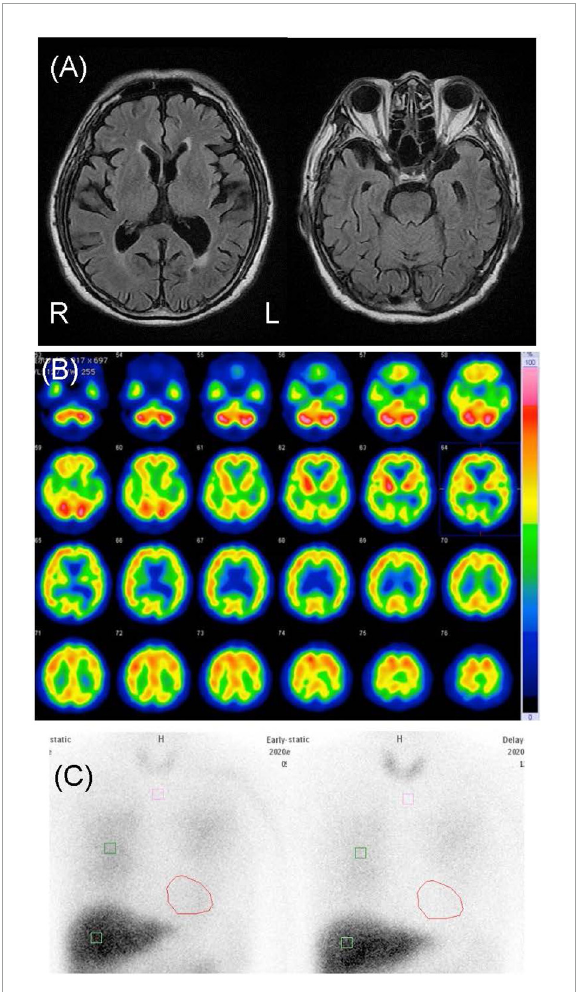
FIGURE1 Neuroimages of case 1. (A) Cranial magnetic resonance images revealed diffuse mild atrophy including the bilateral hippocampus. (B) N-isopropyl-p-[ 123 I] iodoamphetamine single-photon emission computed tomography revealed hypoperfusion in the bilateral occipital and parietal lobes. (C) Cardiac [ 123 I]-metaiodobenzylguanidine scintigraphy revealed heart-to-mediastinum ratios of 1.55 and 1.26 in the early and delayed phases, respectively.